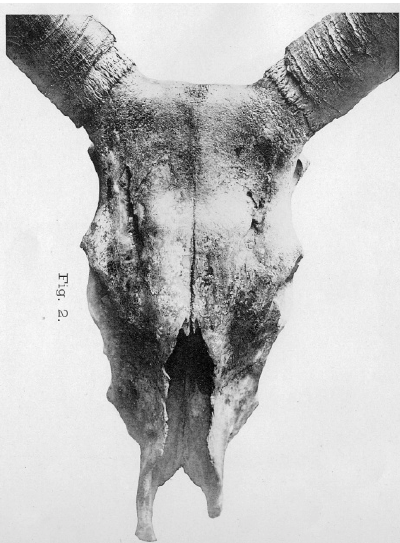
Figure 2. Cattle skull of the macroceros type, according to Dürst